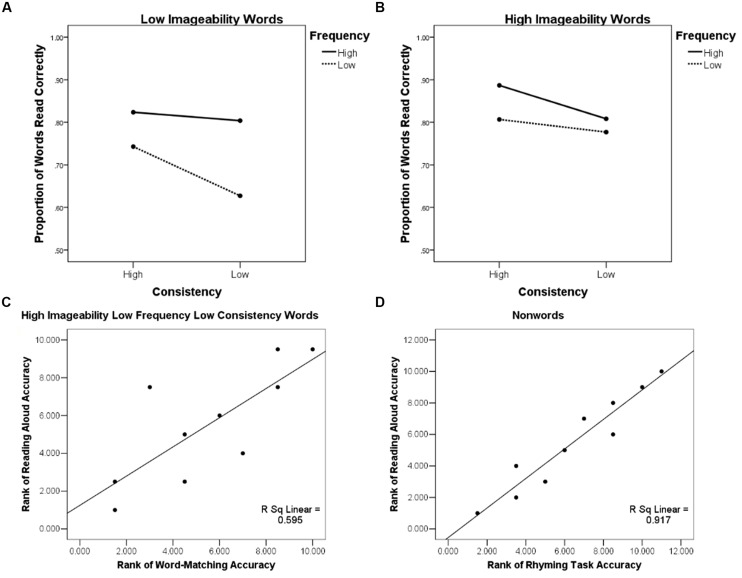
Behavioral effects illustrating the role of semantics in reading aloud: (A) Patient accuracy in the reading aloud task as a function of word imageability, frequency, and consistency showing a three-way interaction of these variables, low imageability words; (B) Patient accuracy in the reading aloud task as a function of word imageability, frequency, and consistency showing a three-way interaction of these variables, high imageability words; (C) Rank-rank association scatter plot of patients’ accuracy in reading aloud words of high imageability low frequency and low consistency and their performance on the word-matching (S) task; (D) Rank-rank association scatter plot of patients’ accuracy in reading aloud non-words and their performance on the rhyming (P) task.